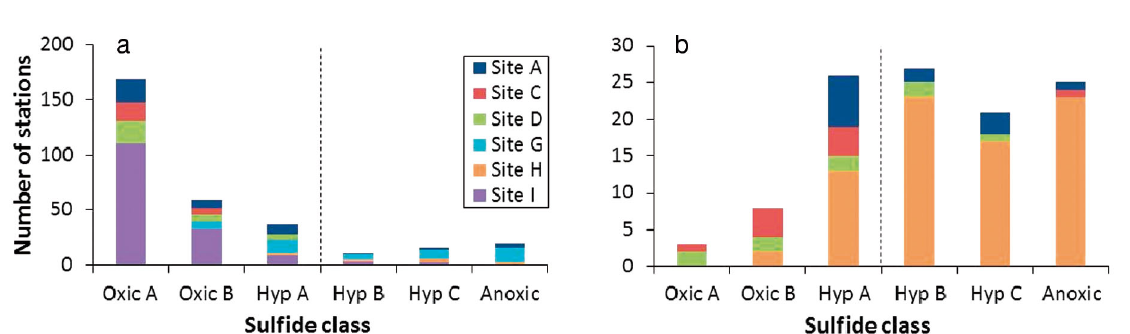
Fig. 9. Numbers of sediment sampling stations at 6 salmon farms classed according to their sulfide concentrations (see Table 1 for classification scheme). Predicted carbon deposition rates (without resuspension) used average daily feeding rates during 1 mo periods including the date of sediment sampling. (a) Stations where DEPOMOD-predicted deposition rates (without resuspension) were low (<5 gC m −2 d −1 ; Oxic A to Hypoxic A according to deposition rates). (b) Stations where DEPOMOD- predicted deposition rates were elevated (>5 g C m −2 d −1 ; Hypoxic B to Anoxic according to deposition rates). Deposition rate data are as in Fig.